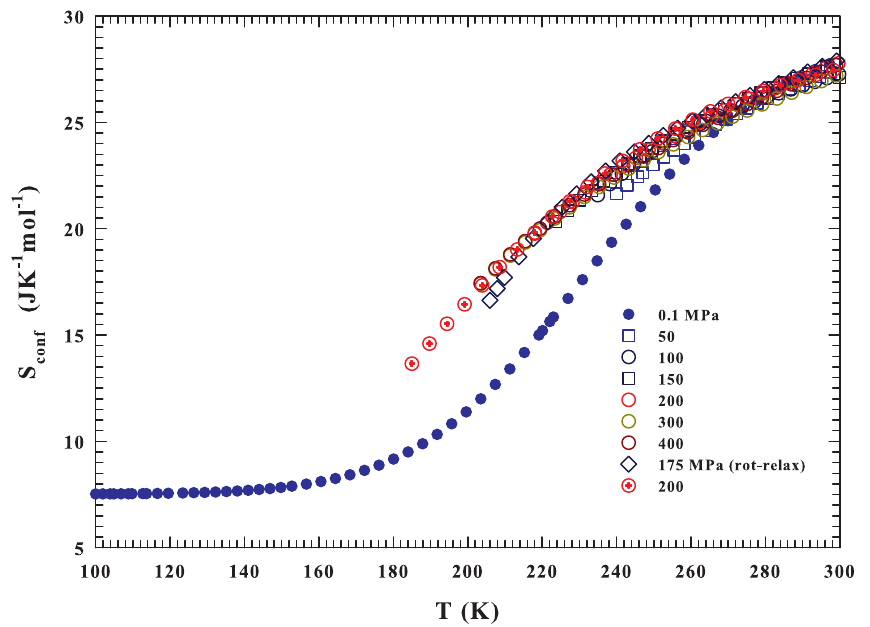
Figure 6. The S conf isobars calculated according to the AG theory are illustrated, at different pressures, in a linear scale for the temperature range 100–300 K.